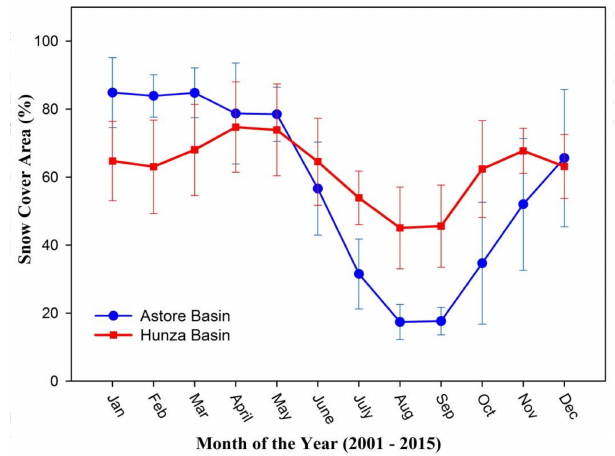
Figure 5. The annual cycle in snow-covered area as a percentage of the total area estimated through the analysis of MODIS snow images for 15 individual years (2001–2015) for the Astore and Hunza basins. The bars indicate standard deviation of snow cover for each month across the